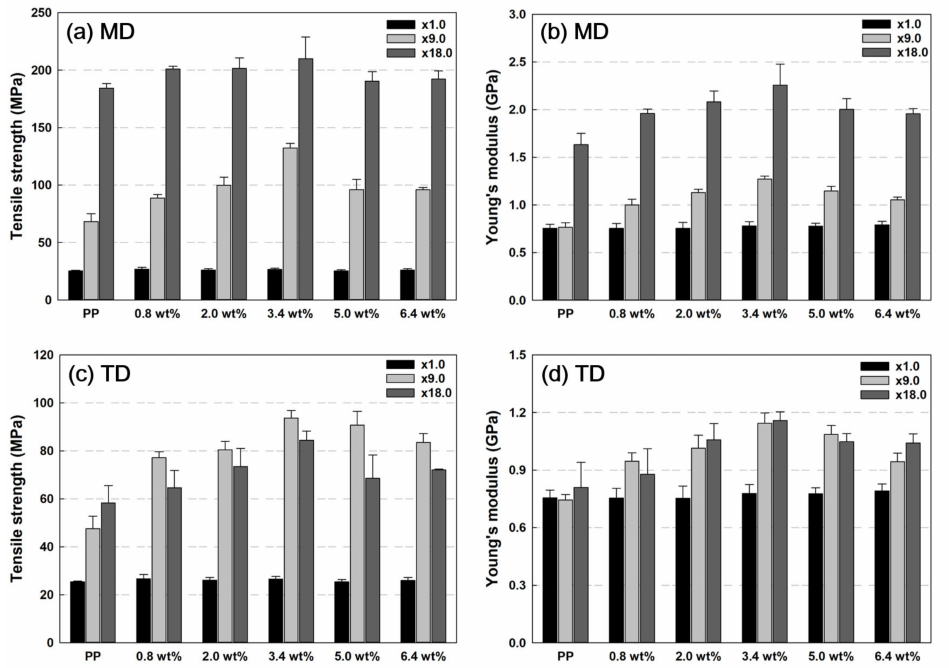
Figure 7. Tensile strength and Young’s modulus results according to MD and TD of PP and PP/nanoclay nanocomposites: Tensile strength in ( a ) MD and ( c ) TD and Young’s modulus in ( b ) MD and ( d )